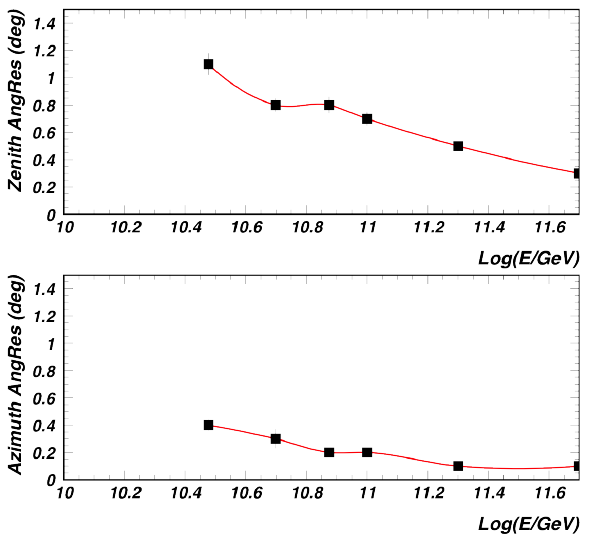
Figure 8. POEMMA’s simulated stereo-reconstructed angular resolution versus UHECR energy.